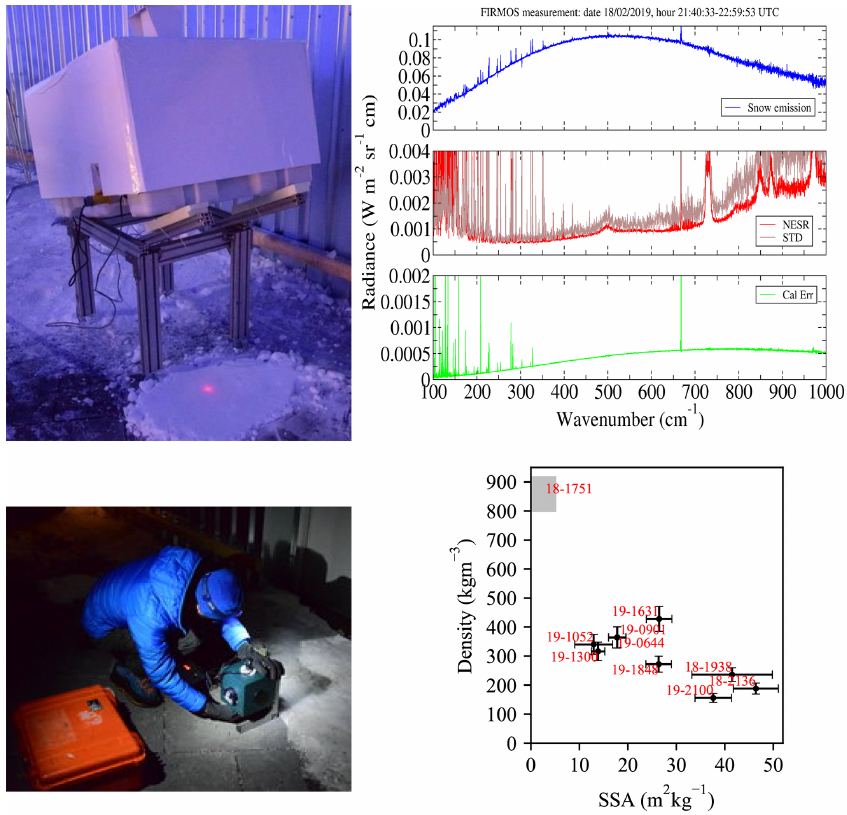
Figure 6. Snow measurements at Zugspitze Summit. FIRMOS in a slant angle during snow emissivity measurement (top left) and the average spectrum with uncertainties of 11 spectra acquired measuring the 18-2136 sample (top right). DUFISSS snow specific surface area (SSA) measurement (bottom left) and density and SSA properties of the snow samples (bottom right, red labels indicate day and time of FIRMOS acquisition). The upper-left grey box corresponds to an ice sample whose parameters were only roughly